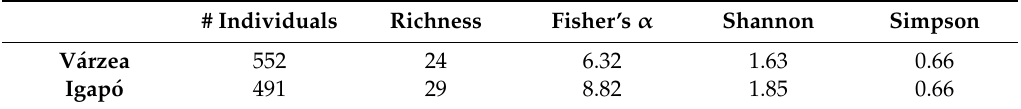
Table 2. Species richness, Fisher’s α , Shannon and Simpson indices for the floodplain forests, v á rzea and igap ó . # Individuals denotes the number of stems sampled in each